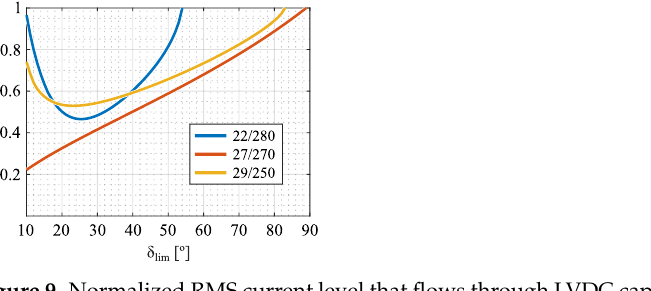
Figure 9. Normalized RMS current level that flows through LVDC capacitor versus δ lim for minimum, nominal, and maximum DC gain voltages at maximum power